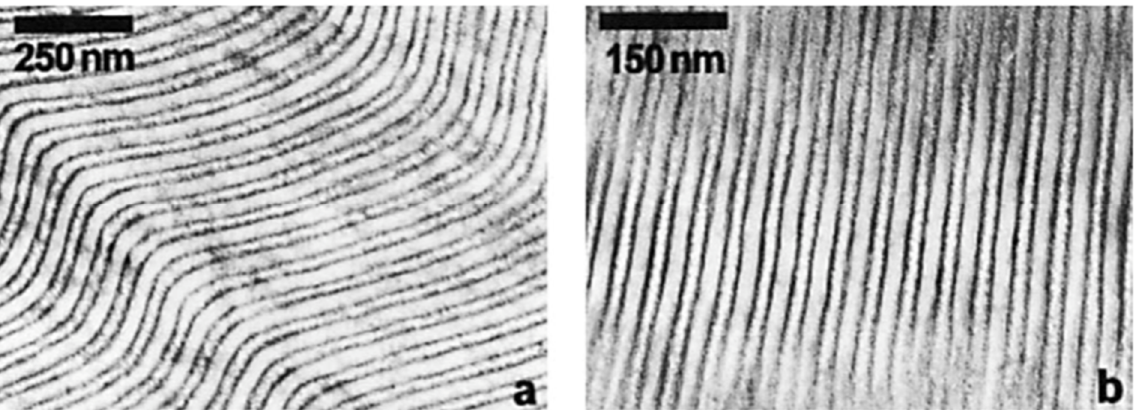
Figure 17. Bulk structures of PolyStyrene-Polydiethylsiloxane block copolymers. Bulk structures of ( a ) PS- b -PDES containing 37 wt% PS and ( b ) PS- b -PDES containing 43 wt% PS (Reprinted with permission from Ref. [19] Copyright 1998 Wiley).